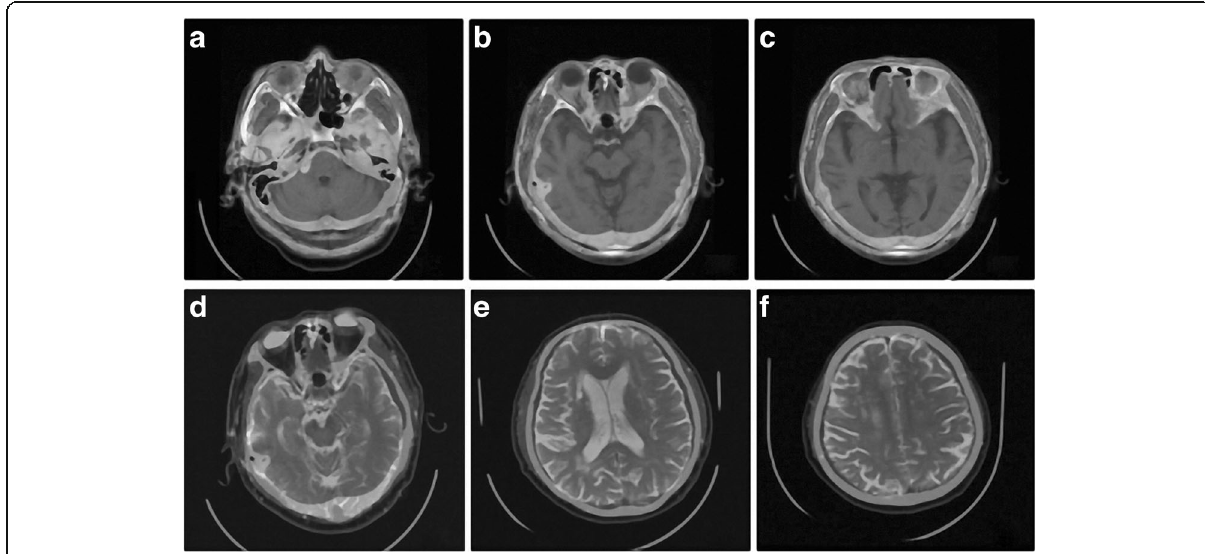
Fig. 14 The α channel fusion result of patient one. a , b , c are the fusion results of CT and T1-MRI, while d , e , f are the fusion results of CT and DWI